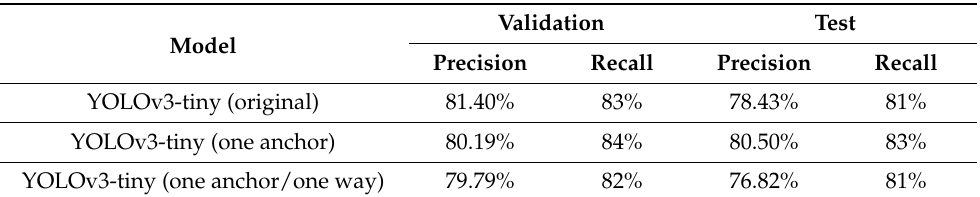
Table 3. Performance comparisons of visible-light pupil object detection among the three YOLO- based models.